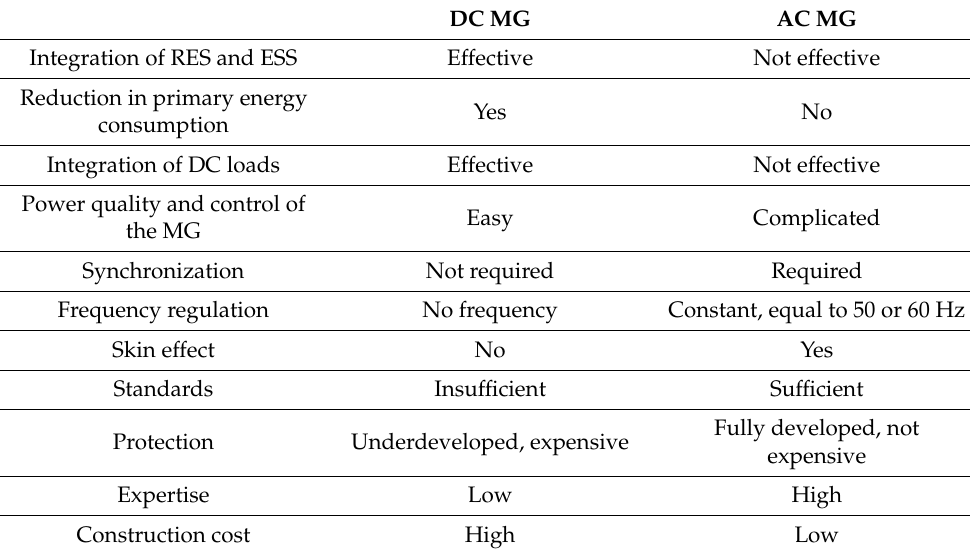
Table 1. Comparison between DC and AC MGs (Data from [15,18]). DC MG AC